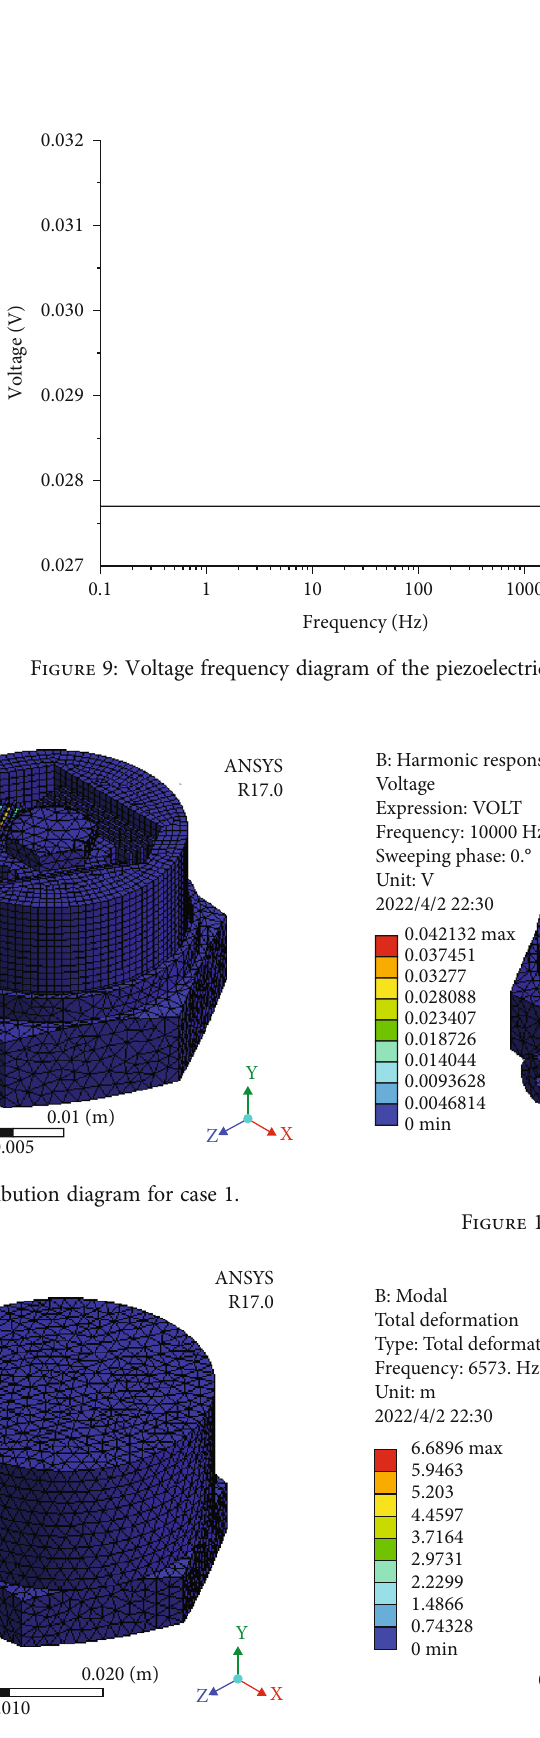
Figure 11: Modal analysis result for case 2.